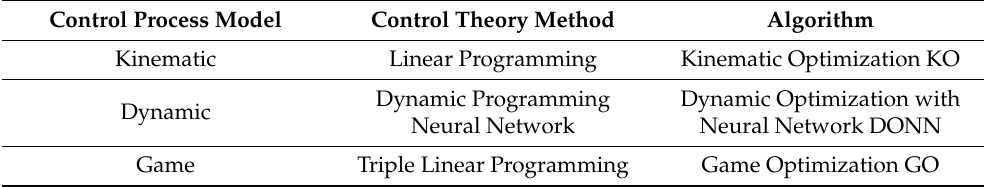
Table 1. General characteristics of trajectory determination algorithms in a group of autonomous vehicles.